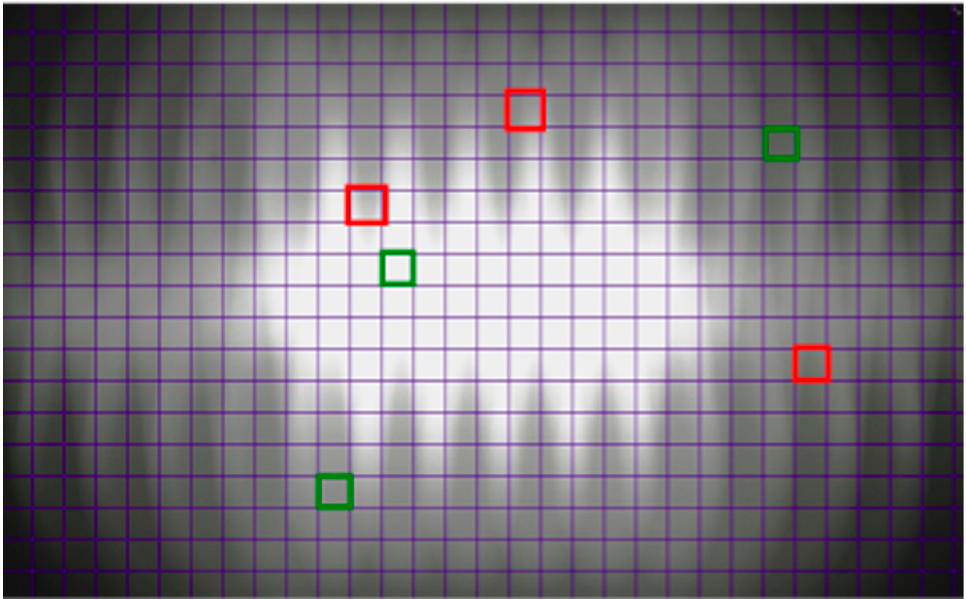
Figure 7. Output image showing the simulated abrasion with homogeneous (green) cells and heterogeneous (red) cells.